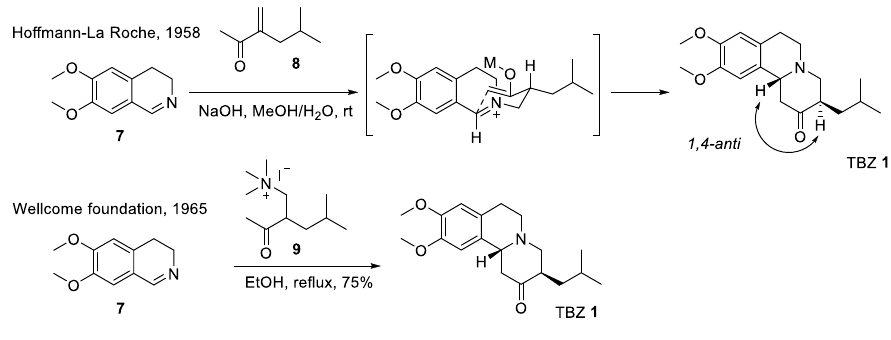
Scheme 1. The classical synthesis of TBZ.